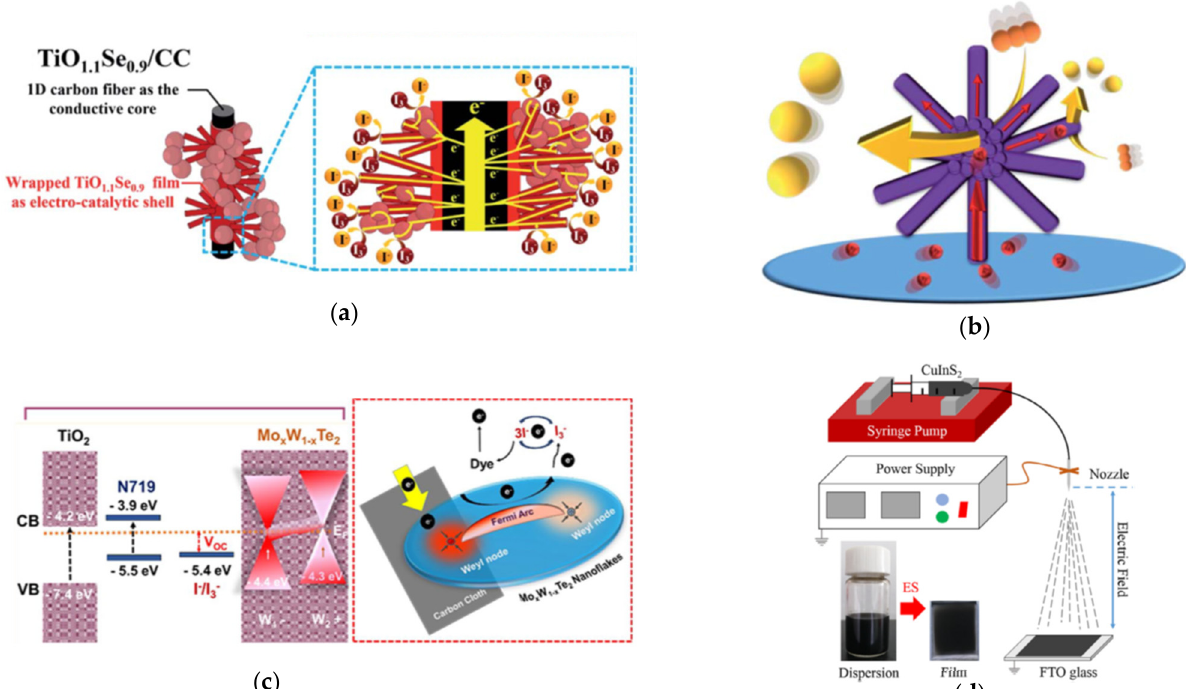
Figure 9. ( a ) The core–shell sketch of the electrodes of TiO 1.1 Se 0.9 /CC and its hierarchical electron transfer route for executing the reduction of I 3 − ions [78]. ( b ) The sketch of the electron transport route of CoSe 2 /CoSeO 3 -UL [79]. ( c ) A schematic representation of the topological Weyl semi-metal (TWS) surface of a T d -Mo 0.29 W 0.72 Te 1.99 /CC [80]. ( d ) Schematic diagram of the electrospray process and the photographs of the CIS dispersion solution and CIS films [81].